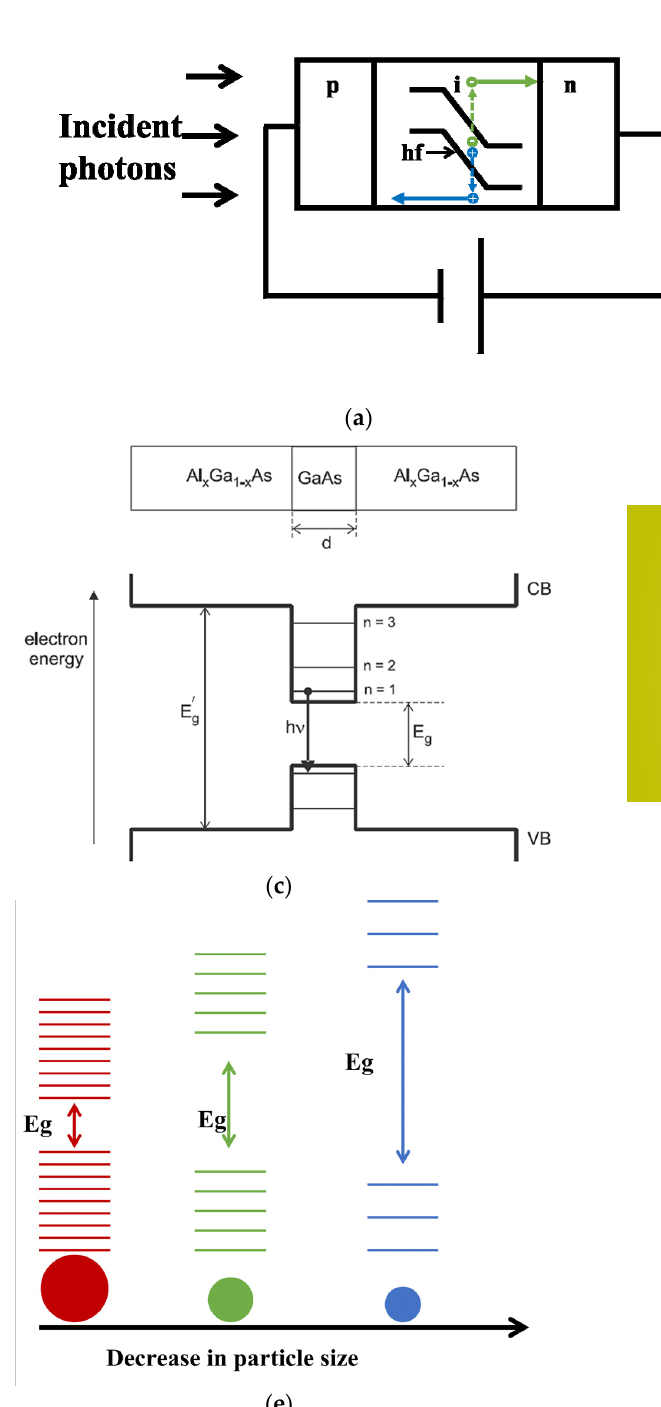
Figure 1. Typical photon detectors: ( a ) PIN photodiode, ( b ) Schottky photodiode, ( c ) quantum well photodetector, ( d ) graphene photodetector, and ( e ) colloidal quantum dots photodetector.